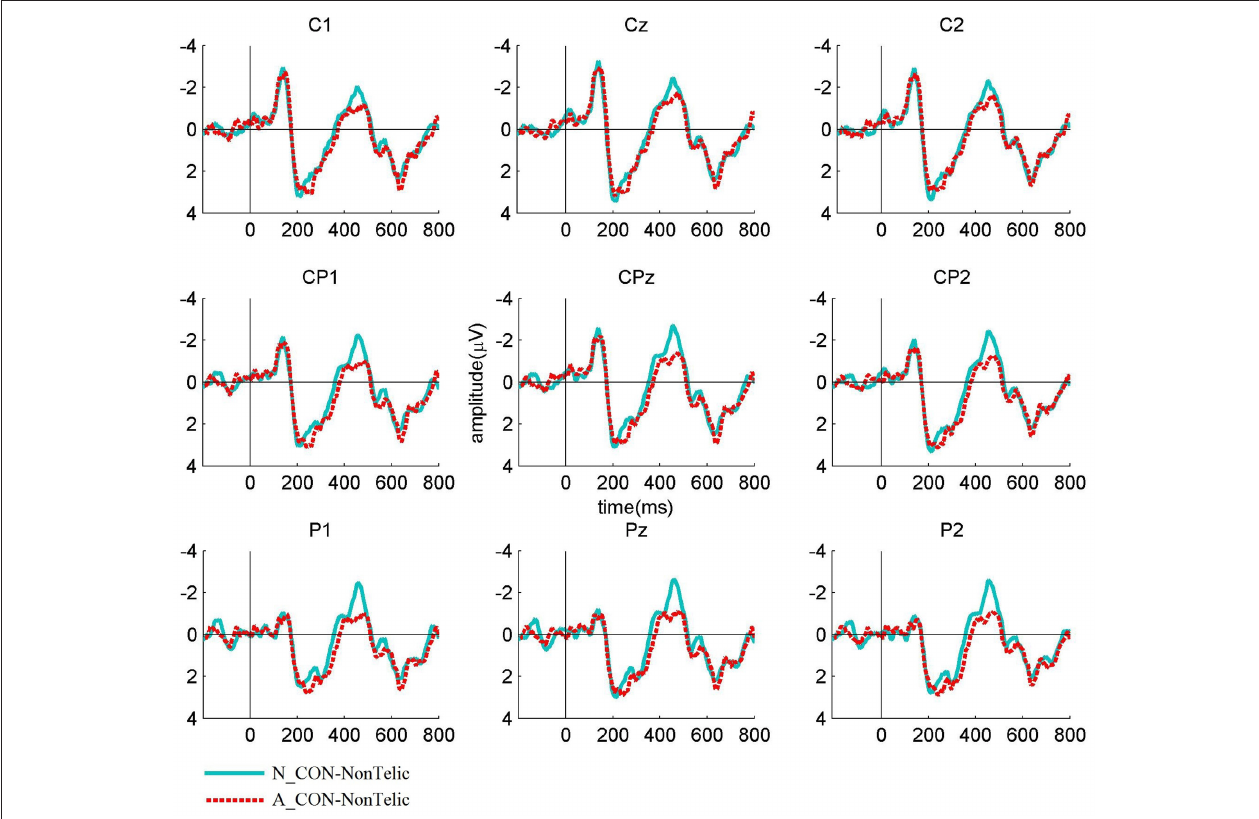
FIGURE 2 | Grand average waveforms elicited by the verbs in NonTelic combinations for Neutral contexts (N_CON) vs. ad-hoc affordance-inducing contexts (A_CON) over nine centro-parietal channels. The waveforms show that the N400 component for the verbs in NonTelic combinations is significantly reduced in A_CON compared to